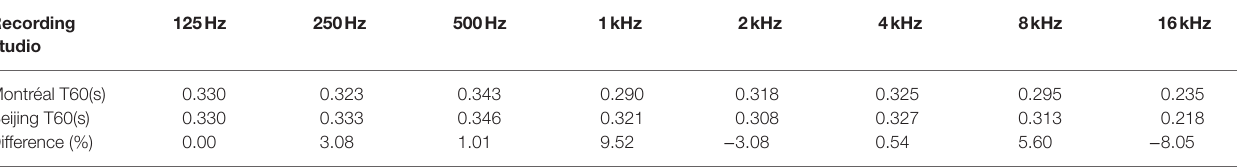
TABLE 1 | The reverberation time T60 of the two recording studios. Recording